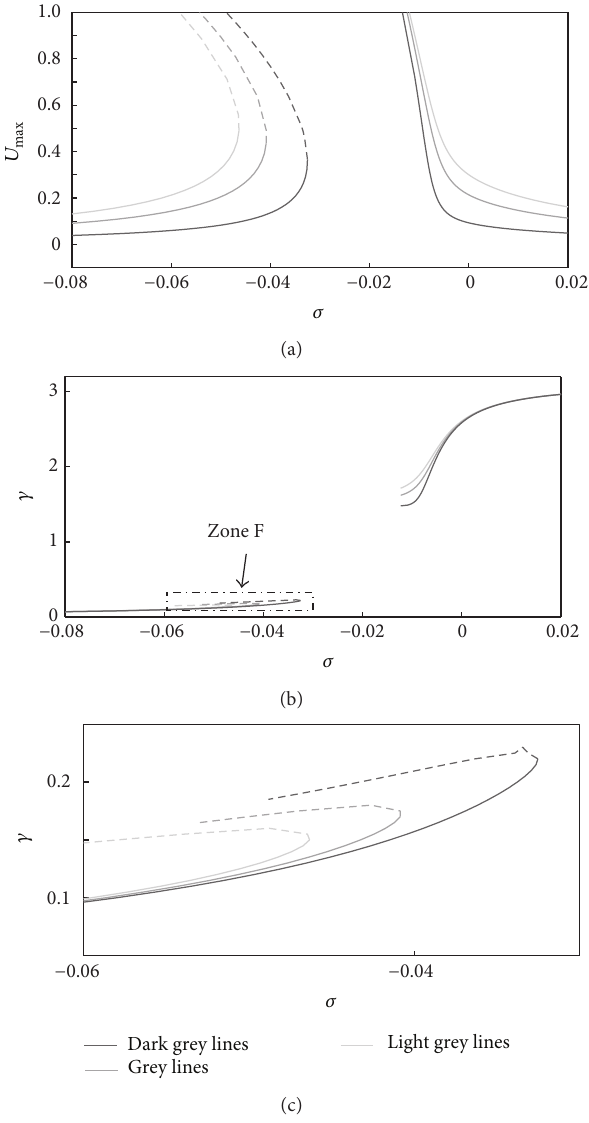
Figure 5: DC bias effect on the frequency response. AC frequency is near natural frequency. (a) Amplitude-frequency response, (b) phase-frequency response, and (c) Zone F detail. MMS is used. Three cases of DC bias are shown in all figures: (i) black lines: 𝛿 0𝐷 = 0.0003, (ii) dark grey lines: 𝛿 0𝐷 = 0.0007, and (iii) light grey lines: 𝛿 0𝐷 = 0.001. The AC voltage, fringe, and damping are 0.26, and 𝑐 = 0.01,